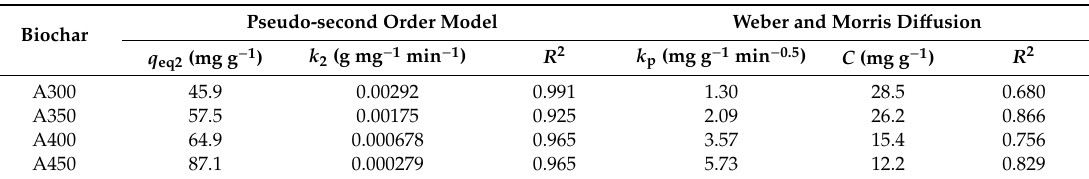
Table 4. The parameters of the pseudo-second order model and intraparticle diffusion model for the